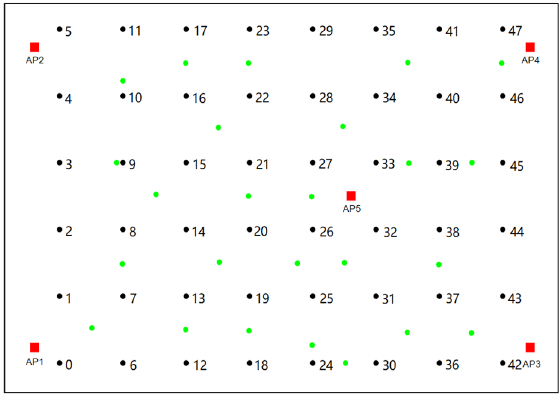
Figure 5. Distribution of the dense acquisition for Wi-Fi fingerprints, with the red “ □ ” representing the five APs, the black dots with the labeled number for the dense site-surveying grids, the green dots for the test-points.